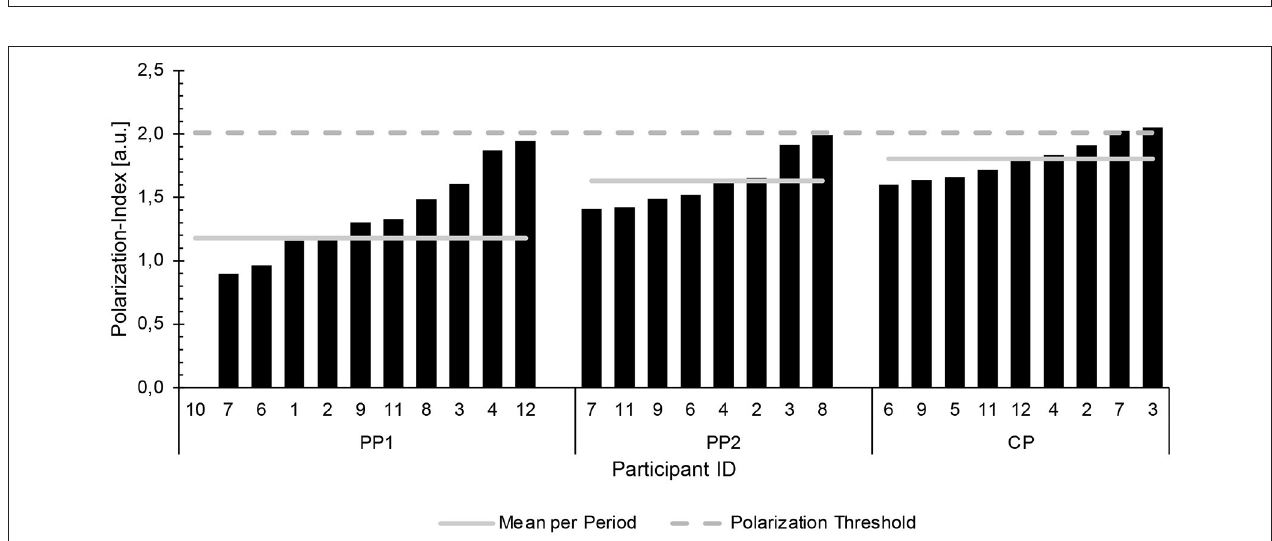
FIGURE 4 | The Polarization Indices (in arbitrary units) for each period and athlete analyzed. PP, preparatory period; CP, competition period.